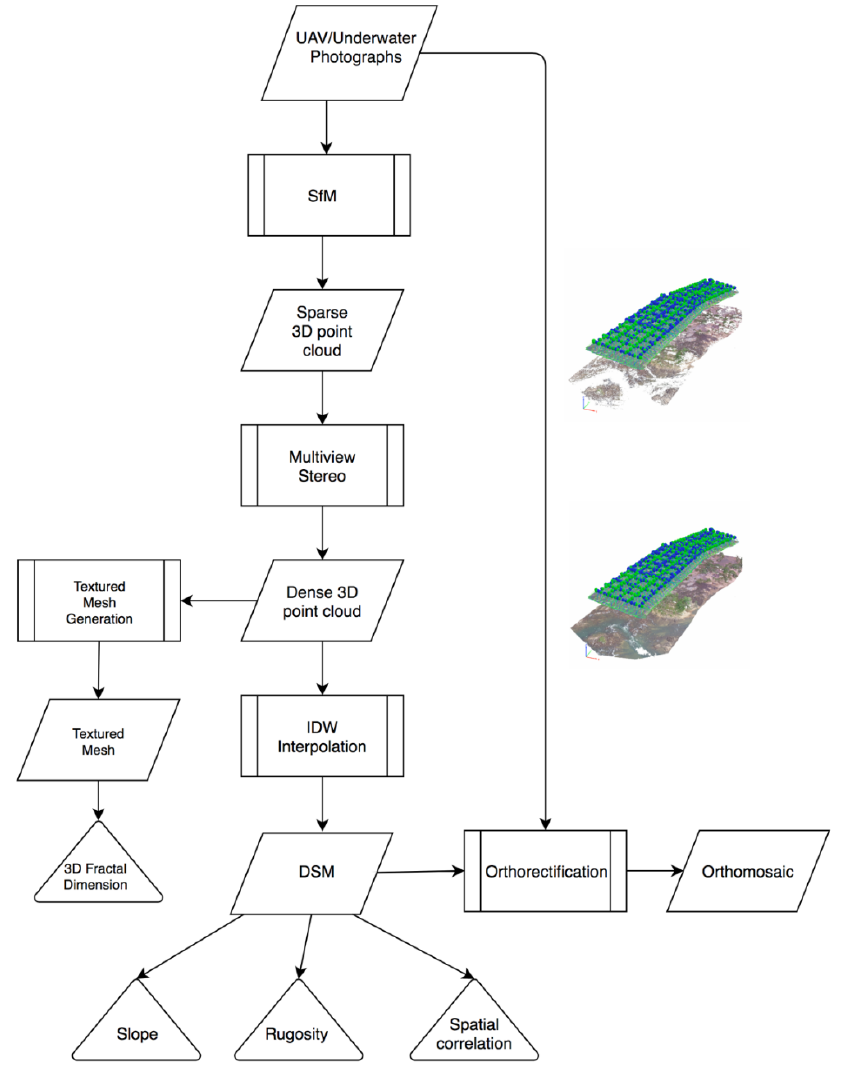
Figure 6. Flow chart of the analytical steps to generate the products (3D point cloud, textured mesh, DSM and orthomosaic) used as inputs to the calculation of the habitat complexity metrics (slope, rugosity, spatial correlation, 3D fractal dimension). For photographs collected from the UAV, the refractive index correction was applied to the DSM prior to the calculation of the habitat complexity metrics. The sparse and dense point clouds from the Xadá study site are shown to the right of the flowchart along with the position of the photographs used for the analysis. Examples of the DSM and orthomosaic products are shown in the results section.